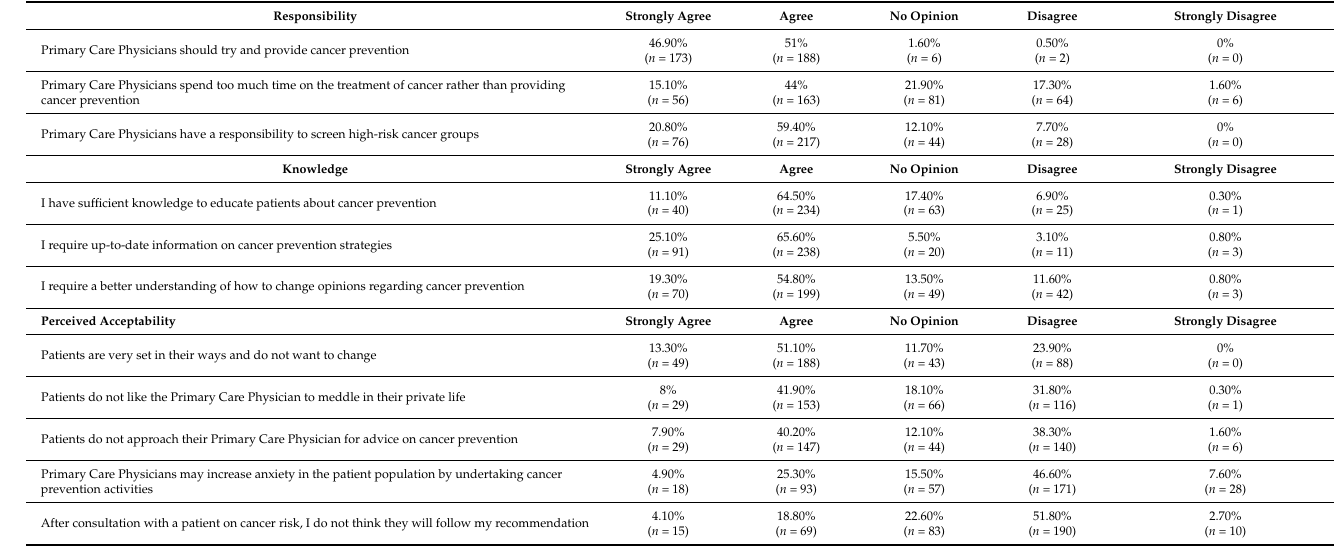
Table 4. Perceived responsibility, knowledge and acceptability of a Primary Care Physician in cancer prevention